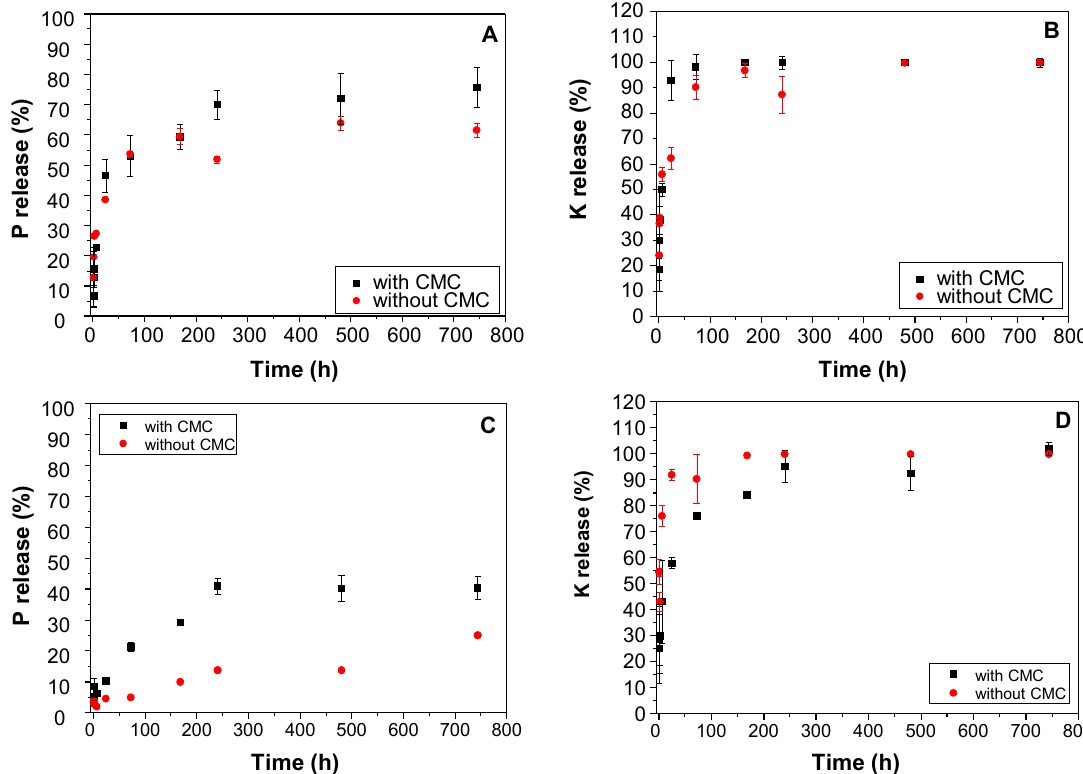
Figure 11. Comparison between release curves for the MgAl 200 /K 2 HPO 4 system (Method 2) ( A,B ) and the MgFe 200 /K 2 HPO 4 system (Method 1) ( C , D ) with CMC, and without CMC.